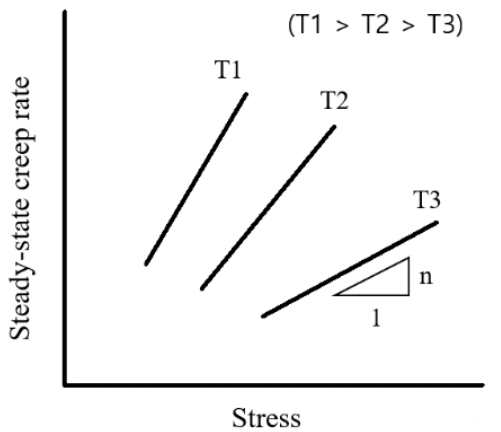
Figure 9. Schematic representation of steady-state strain rate versus stress.